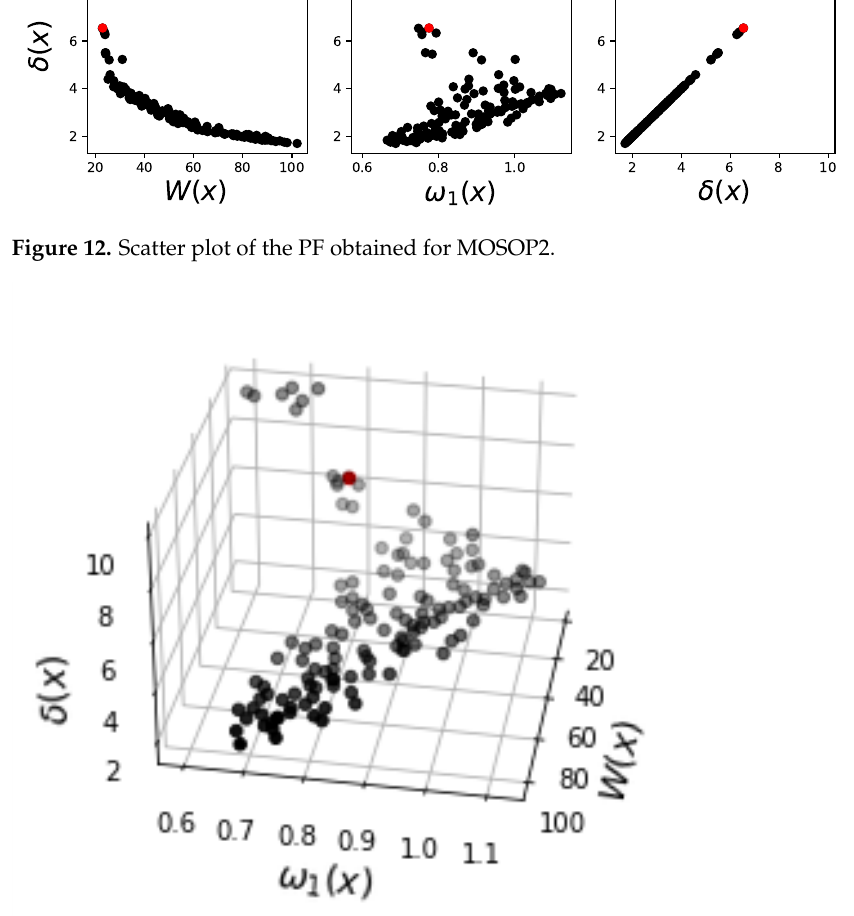
Figure 13. 3D Visualization of the PF obtained for